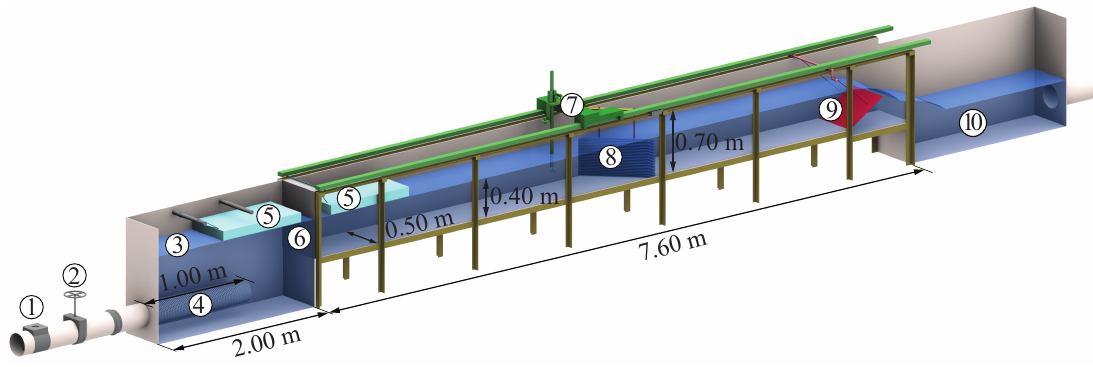
Figure 1. Sketch of the experimental channel for the detailed model investigation including